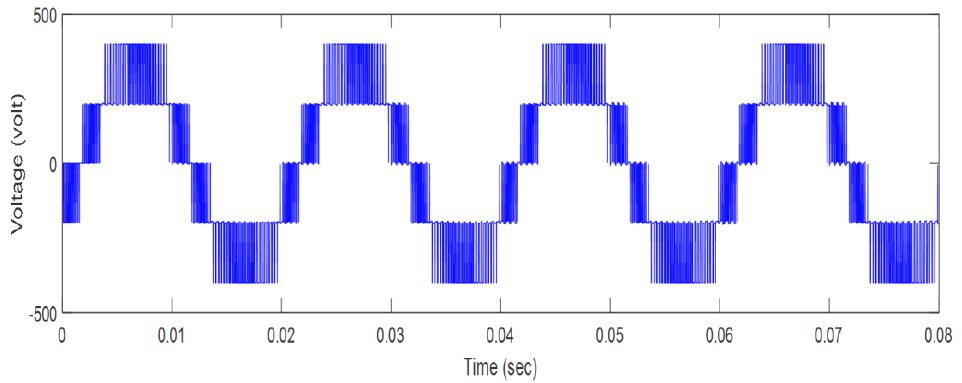
Figure 14. A five-level FC-MLI Simulink model’s voltage output. Table 5. Switching diagram of an FC five-level Sinusoidal PWM-MLI. S witching States Voltage